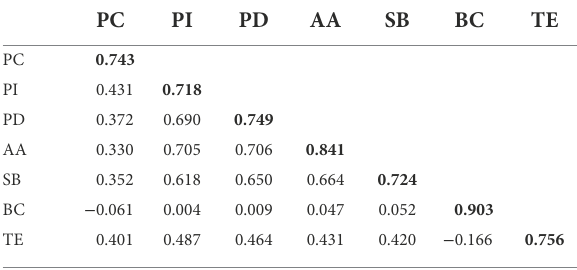
TABLE 4 Discriminant validity and criterion-related